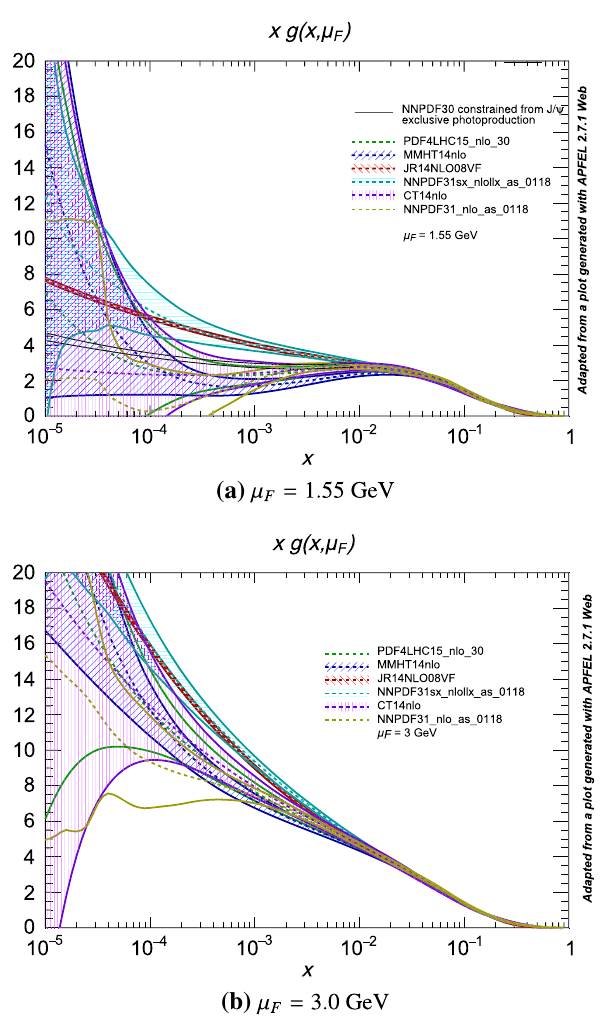
Fig. 2 Gluon PDFs as encoded in PDF4LHC15_nlo_30 [60], JR14NLO08VF [61], NNPDF31sx_nlonllx_as_0118 [57], CT14nlo [62], MMHT14nlo [63], NNPDF31_nlo_as_0118 [64] for two scale values: a 1.55 GeV and b 3 GeV. In addition, we have added on a (solid black lines) the resulting constraints on NNPDF3.0 obtained by Flett et al. under some assumptions [65] from J /ψ exclusive photoproduction. [These plots have been adapted from plots generated by APFEL web